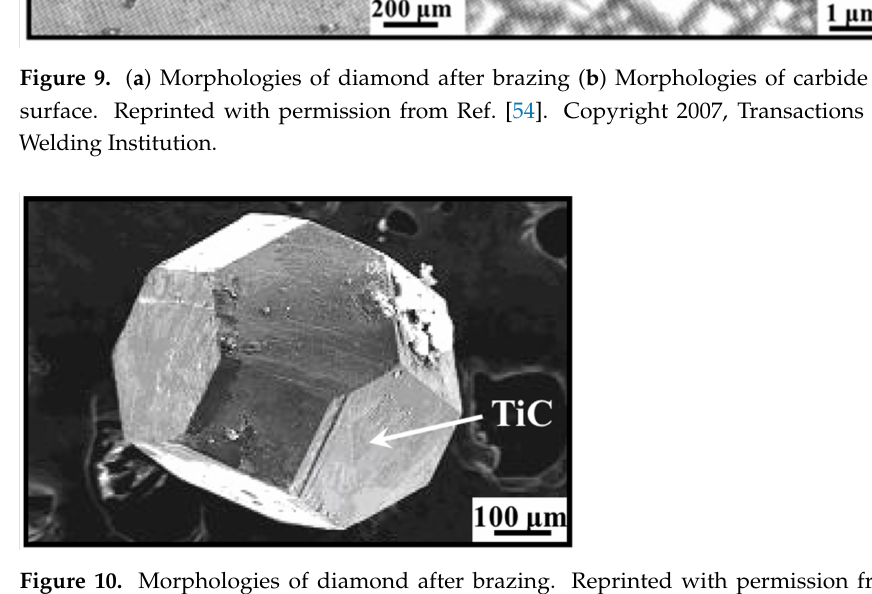
Figure 10. Morphologies of diamond after brazing. Reprinted with permission from Ref. [55]. Copyright 2009, Elsevier.